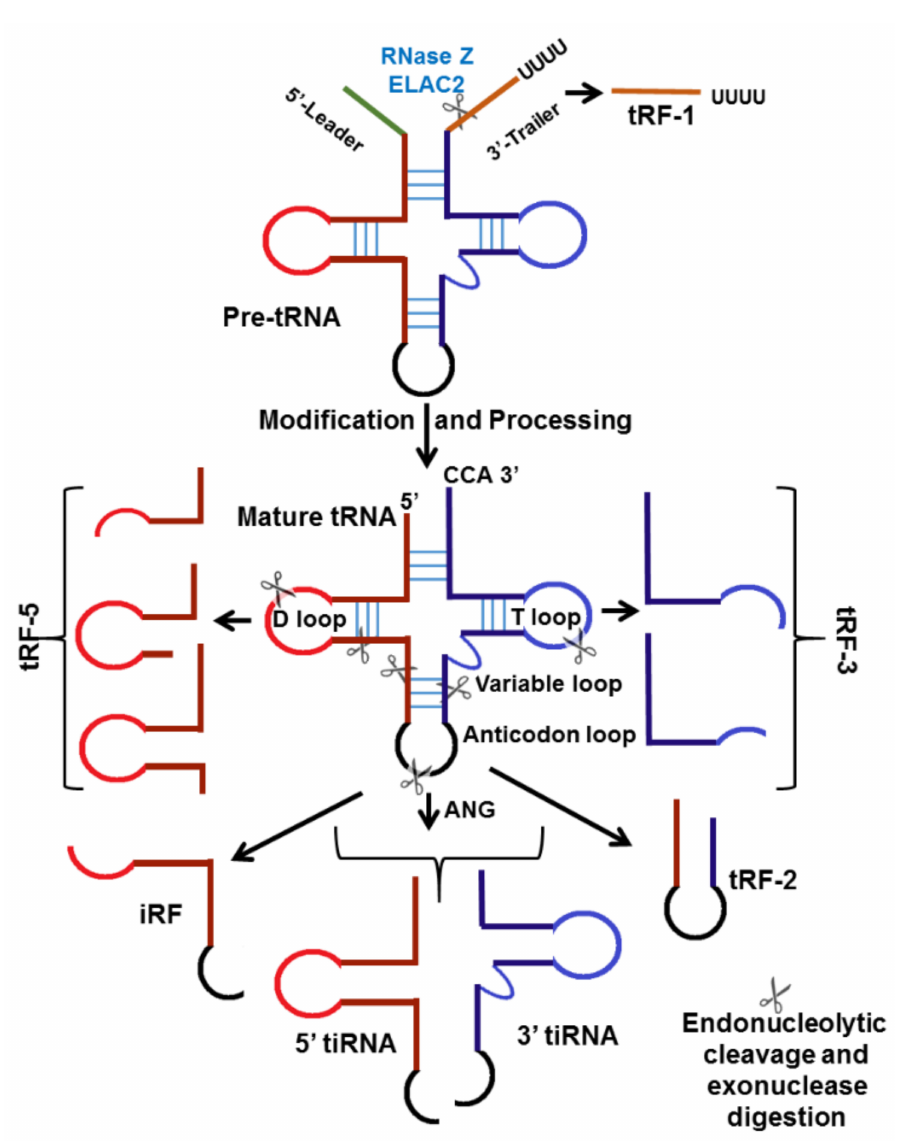
Figure 2. Biogenesis and function of tRNA-derived small RNAs: Different types of tRNA-derived RNA fragments produced from either pre-tRNAs or mature tRNAs. The tRF-1 series is produced by RNase Z (or ELAC2) cleavage of the pre-tRNA during tRNA processing. Mature tRNA can be cleaved in the anticodon loop by angiogenin (ANG) to produce the 5 (cid:48) -tiRNA and 3 (cid:48) -tiRNA series under stress conditions. tRF-2 is a tRNA fragment containing an anti-codon loop generated by an unknown cleavage method. Cleavage in the T-loop results in the production of the 3 (cid:48) -tRF series. The 5 (cid:48) -tRF series is derived from the 5 (cid:48) -end of mature tRNAs by endonucleolytic cleavage and exonuclease digestion in the